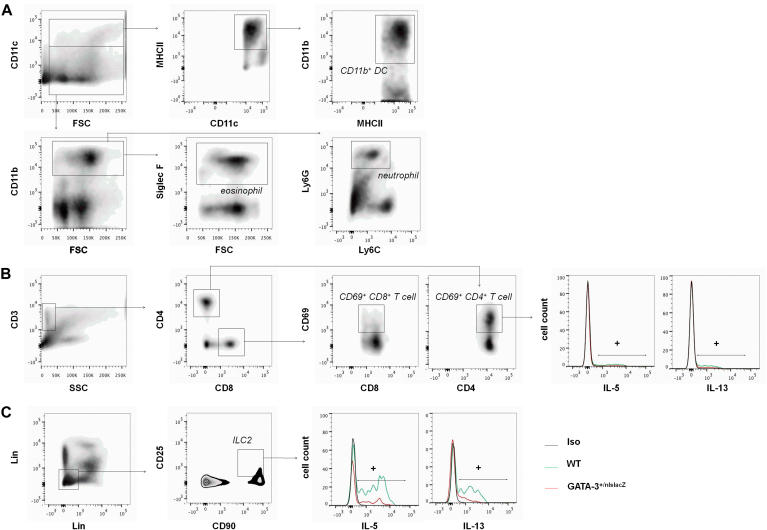
Representative density plots and gating strategy of all analyzed cell populations in lung tissue. WT mice were exposed to 25 μg of DEPs plus 1 μg of HDM. A, Pulmonary CD11b+ DCs were identified as CD11c+, MHCII+, and CD11b+. Eosinophils were gated as CD11c−, CD11b+, and Siglec-F+. Neutrophils were CD11c−, CD11b+, Ly6G+, and Ly6C+. B, CD4+ T cells were gated as CD3+, CD4+, CD8−, and CD69+. CD8+ T cells were characterized as CD3+, CD4−, CD8+, and CD69+. Intracellular IL-5 and IL-13 production of CD4+ T cells was investigated. C, ILC2s were identified as Lin− (CD3−, CD5−, NK1.1−, TCRβ−, CD11c−, CD11b−, and CD45R−), CD25+, and CD90+. Intracellular IL-5 and IL-13 production of ILC2s was investigated. FSC, Forward scatter; SSC, side scatter.